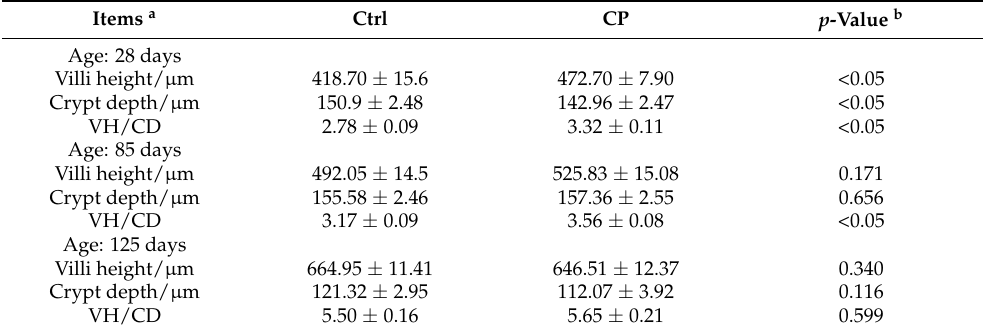
Table 8. Effects of compound probiotics on the morphological structure in the ileum mucosa of ducks. Items a p -Value